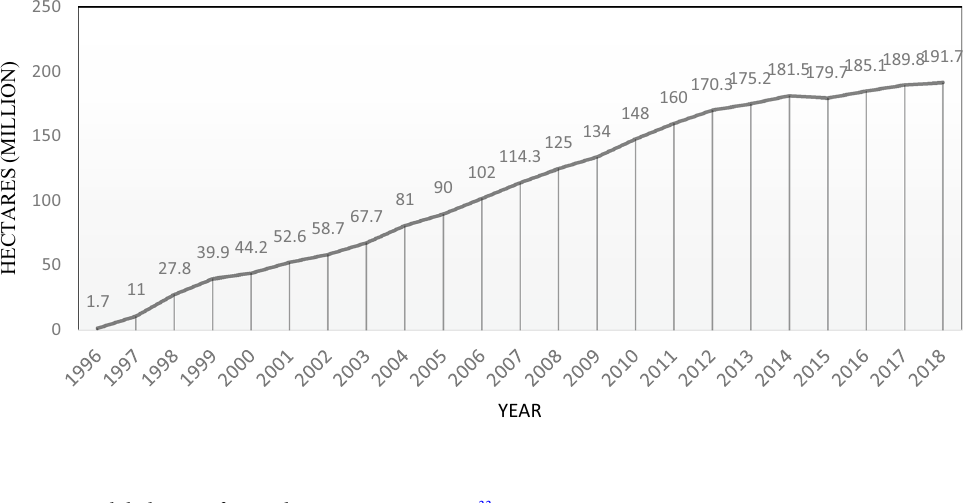
Figure 1. Global Area of Biotech Crops, 1996 to 2018 33